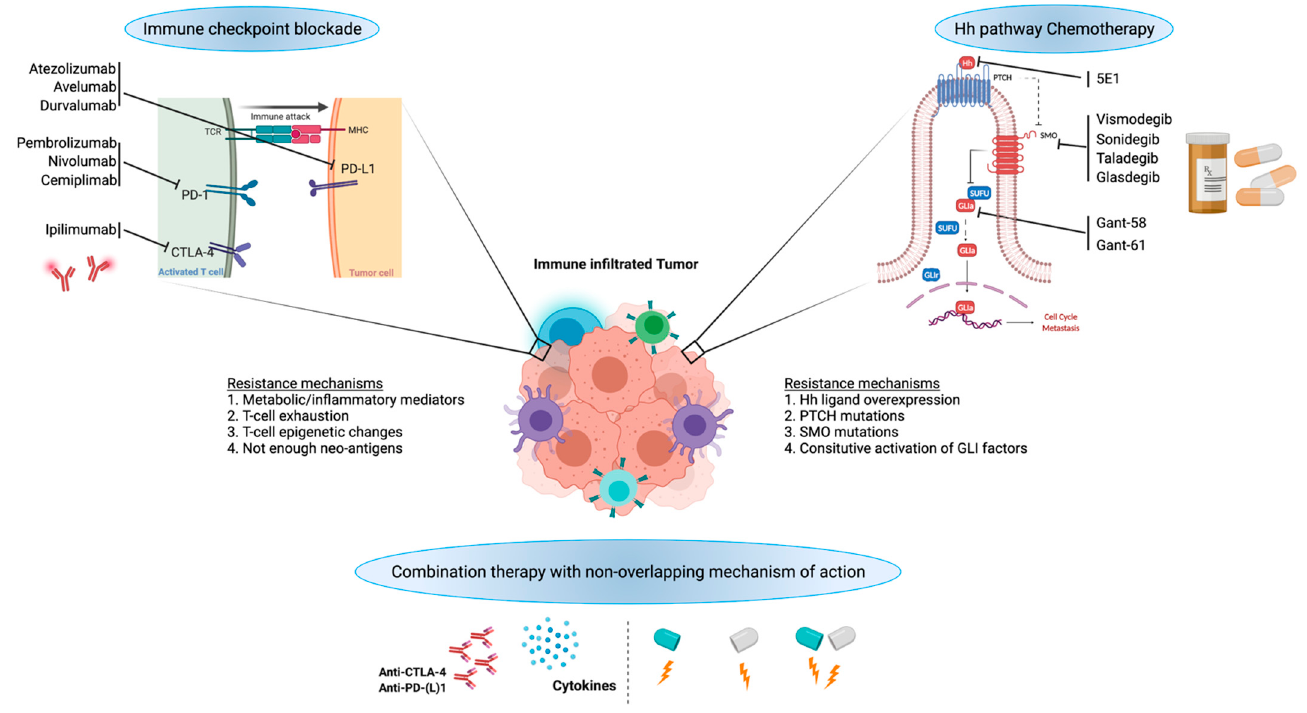
Figure 2. Potential for combination of HH signaling inhibition with immunotherapy.